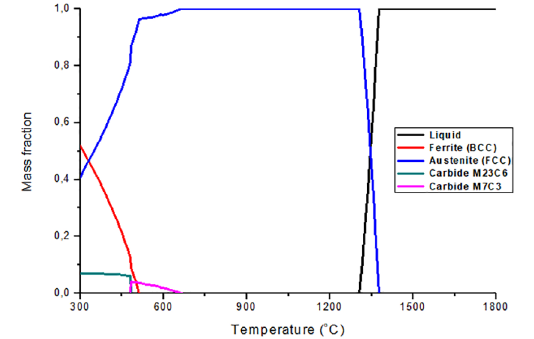
Figure 4. Mass fraction diagram of the 26% manganese steel. Source: author The mass fraction diagram of the 28%